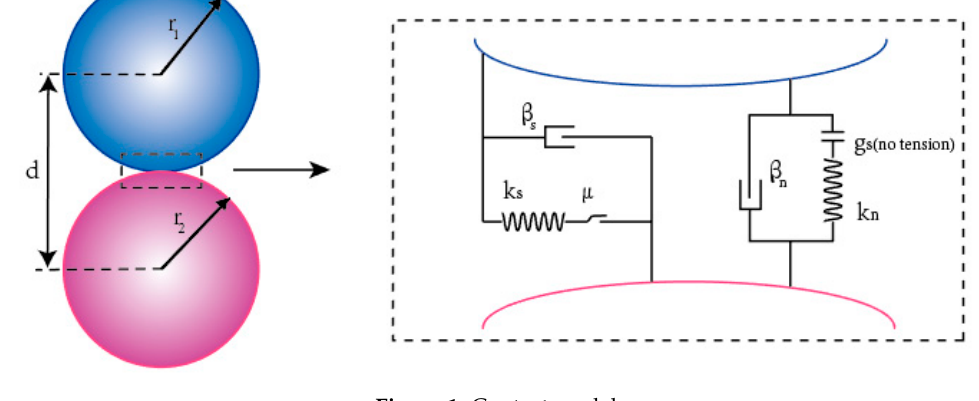
Figure 1. Contact Figure 1. Contact model.